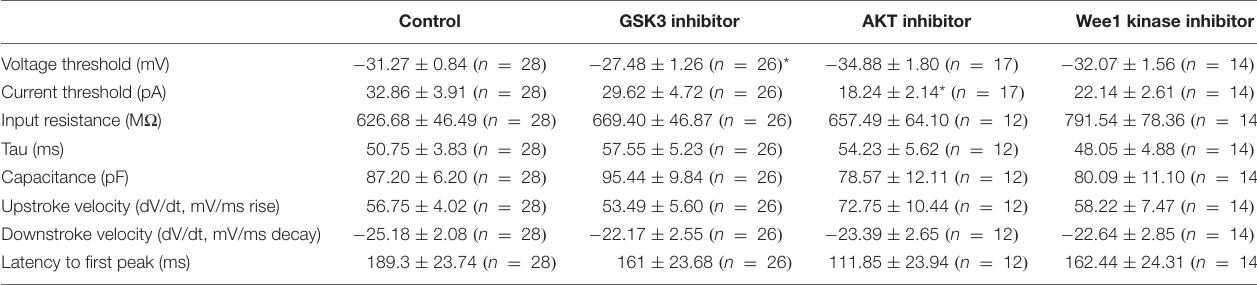
FIGURE 5 | Treatment with AKT inhibitor triciribine increases the intrinsic excitability of primary hippocampal neurons. (A) Representative traces of action potential trains from neurons treated with 0.25% DMSO (control), 5 µ M GSK3 inhibitor CHIR99021, 25 µ M AKT inhibitor triciribine and 5 µ M Wee1 kinase inhibitor. (B) Treatment with the AKT inhibitor triciribine increased the maximum number of action potentials recorded from primary hippocampal neurons ( p = 0.0457) compared to DMSO. (C) Treatment with AKT inhibitor triciribine increased the firing frequency of primary hippocampal neurons at the current threshold (40 pA) ( p = 0.0472) compared to DMSO. (D) The AKT inhibitor triciribine decreases the current threshold of treated primary hippocampal neurons ( p = 0.0201) compared to DMSO. (E) GSK3 inhibitor CHIR99021 increased the voltage threshold of primary hippocampal neurons ( p = 0.0475) compared to DMSO. All data are mean ± SEM ∗ p < 0.05 by one-way ANOVA with Dunnett’s multiple comparisons test or Kruskal Wallis ANOVA with Dunn’s multiple comparisons. TABLE 2 | Summary of